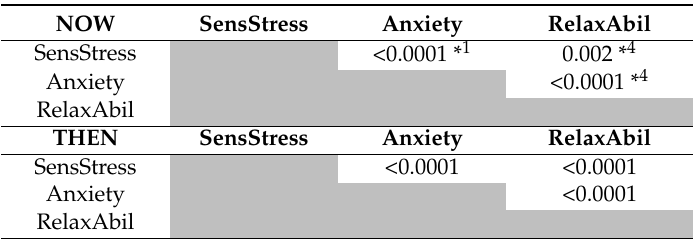
Table A8. Hypothalamic–pituitary–adrenal axis 1: Stress and relaxation.